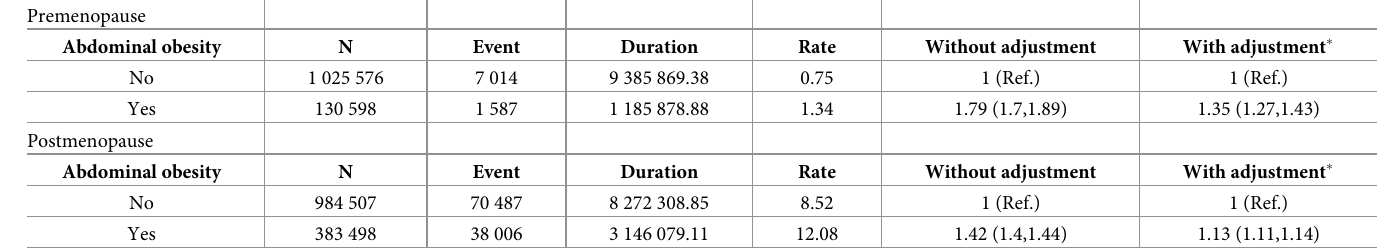
Table 3. Cox proportional hazards regression analysis for the development of vertebral fracture according to abdominal obesity status based on waist circumfer- ence in the premenopausal and postmenopausal groups.